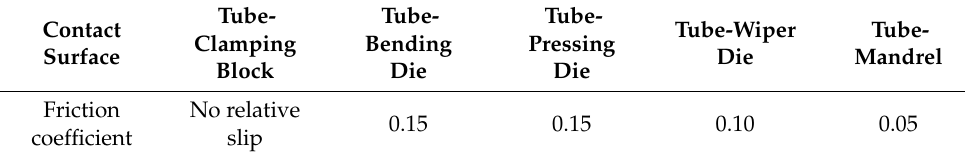
Table 2. Coefficient of friction.